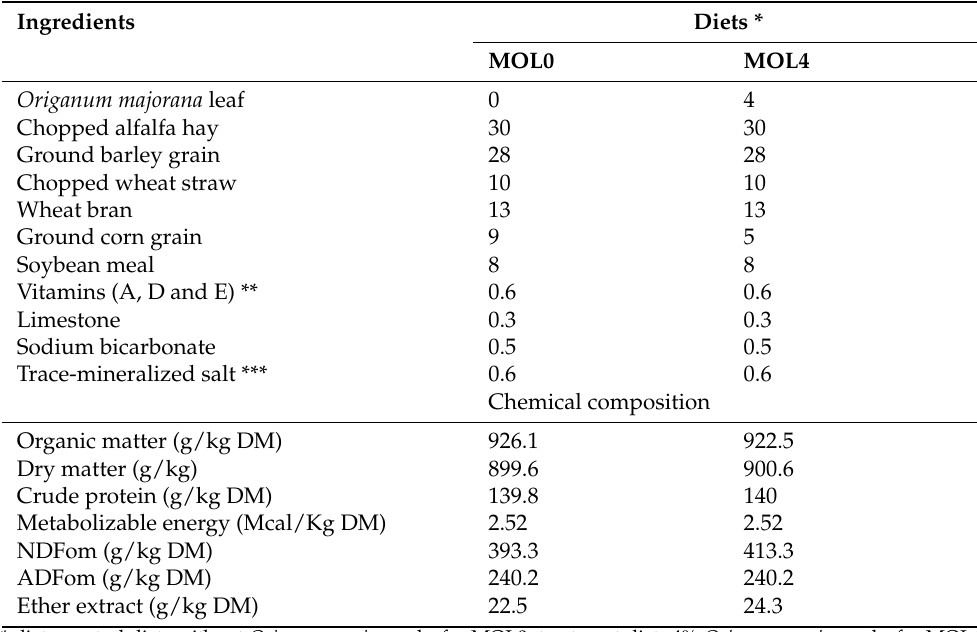
Table 1. Nutrient composition and ingredients of diets in the current